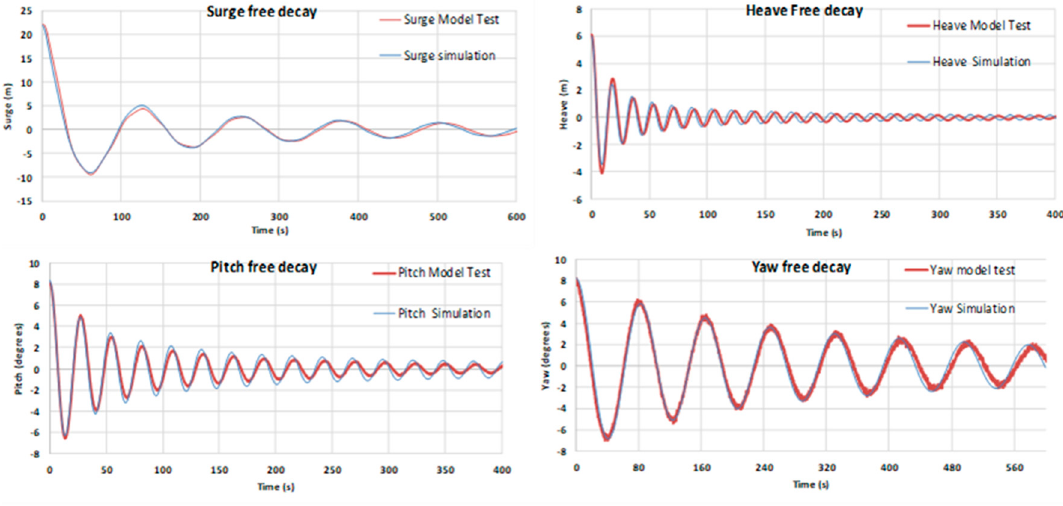
Figure 6. Free decay test comparison between model test and simulation for surge, heave, pitch, and yaw.